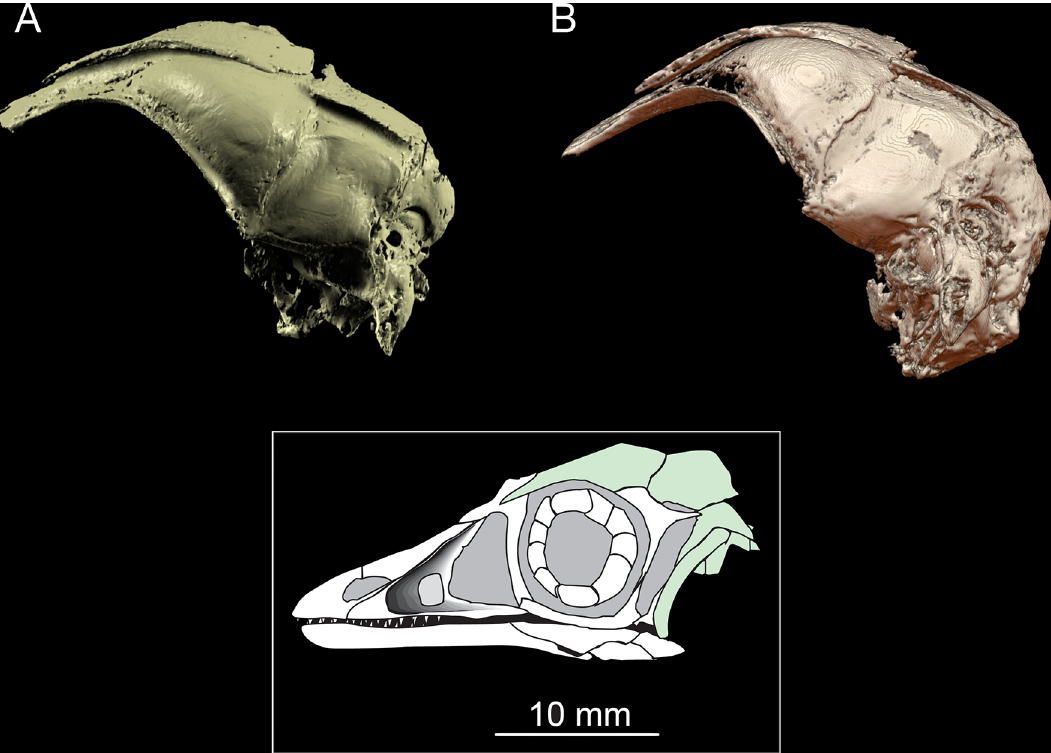
Figure 7. Shape analysis and segmentation of a CT scan of the skull of the London specimen (BMNH 37001) of Archaeopteryx lithographica for a study of the brain and inner ear and its adaptation to flight 50 . Specimen was scanned at UT Austin’s High-Resolution X-ray CT Facility at low and high X-ray energies (120 kV and 180 kV). 1024 650 voxels and the voxel size was 20 20 46 µ m . ( A ) The The resulting matrix data size was 1024 × × × × 100 h of manual segmentation. (Visualization using Mimics original segmentation (Fig. 1b in 50 ) which took ∼ v7.3, https:// www. mater ialise. com) ( B ) Automated SWD analysis. The SWD detects continuous distributions of similar intensity and quantitatively characterizes their shape. Subsequent to the SWD analysis, a segmentation algorithm extracts the skull. The total processing time to produce figure ( B ) was 7 min and required no user